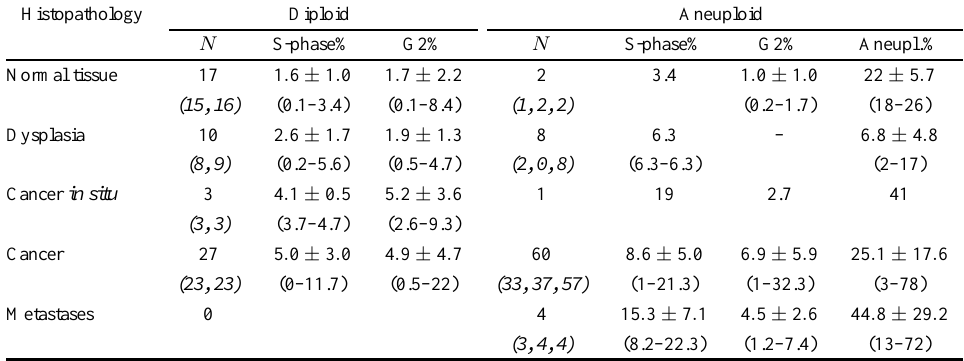
DNA ploidy, S-phase and G2 fractions, and % aneuploid cells found in 133 cellpopulations from tumour and adjacent normal tissue of 52 patients with gallbladder cancer